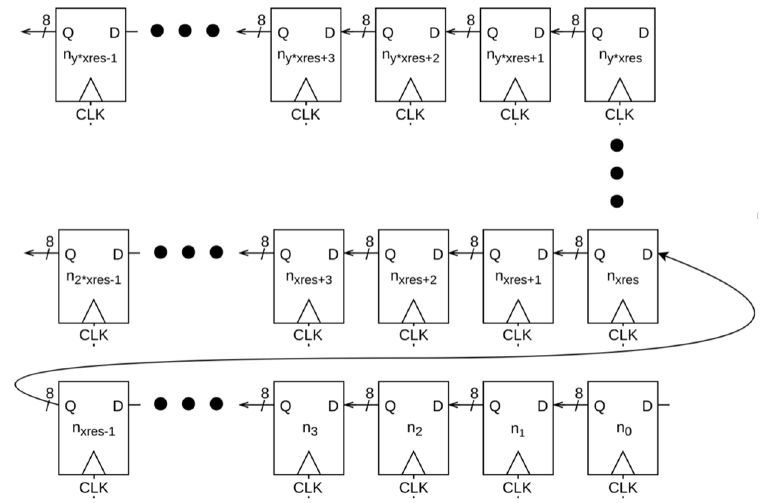
Figure 5. Using shift registers as line buffers.